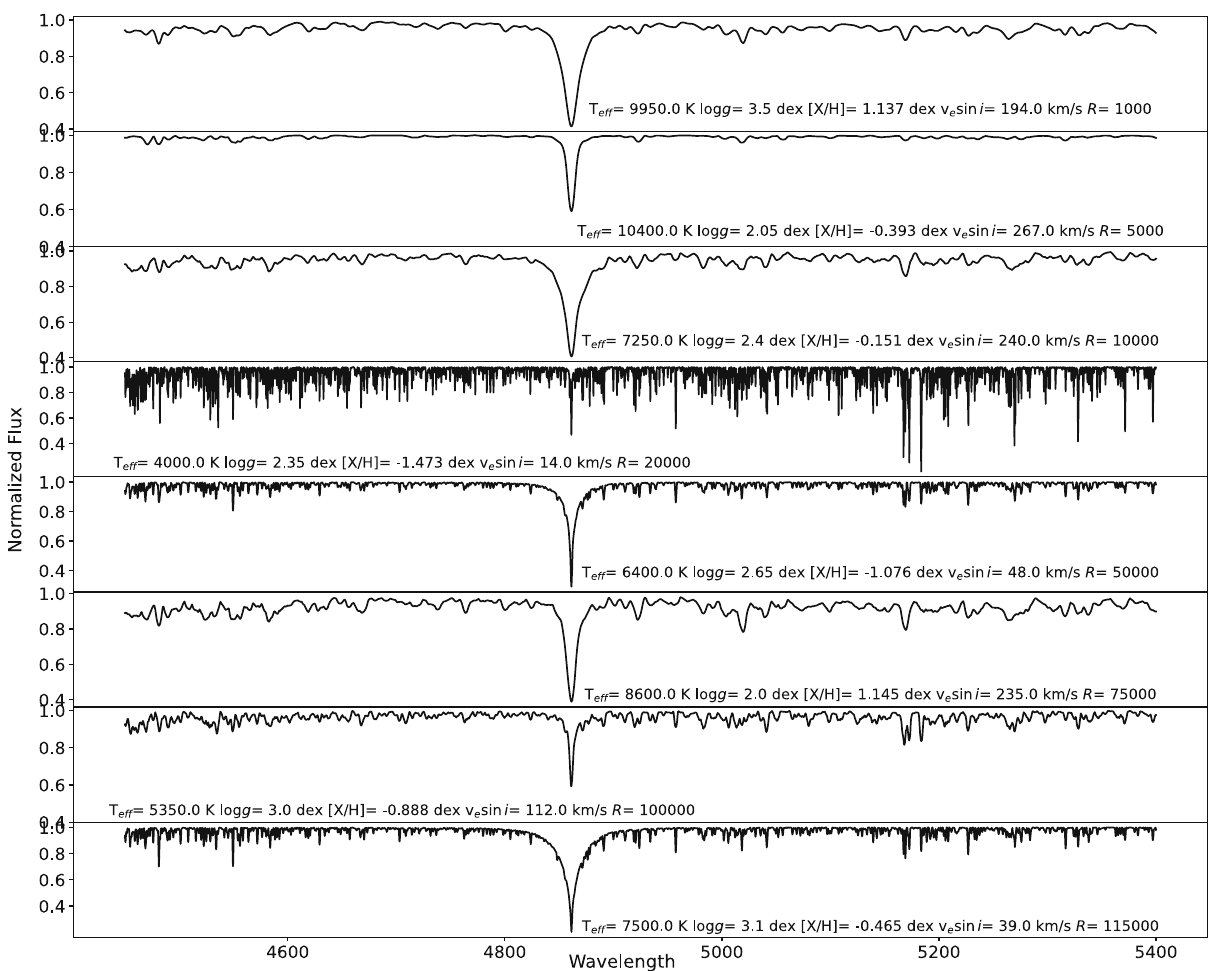
Figure 1: Sample of synthetic spectra calculated with di ff erent stellar parameters and spectral resolutions. These noise - free spectra are normalized to the local